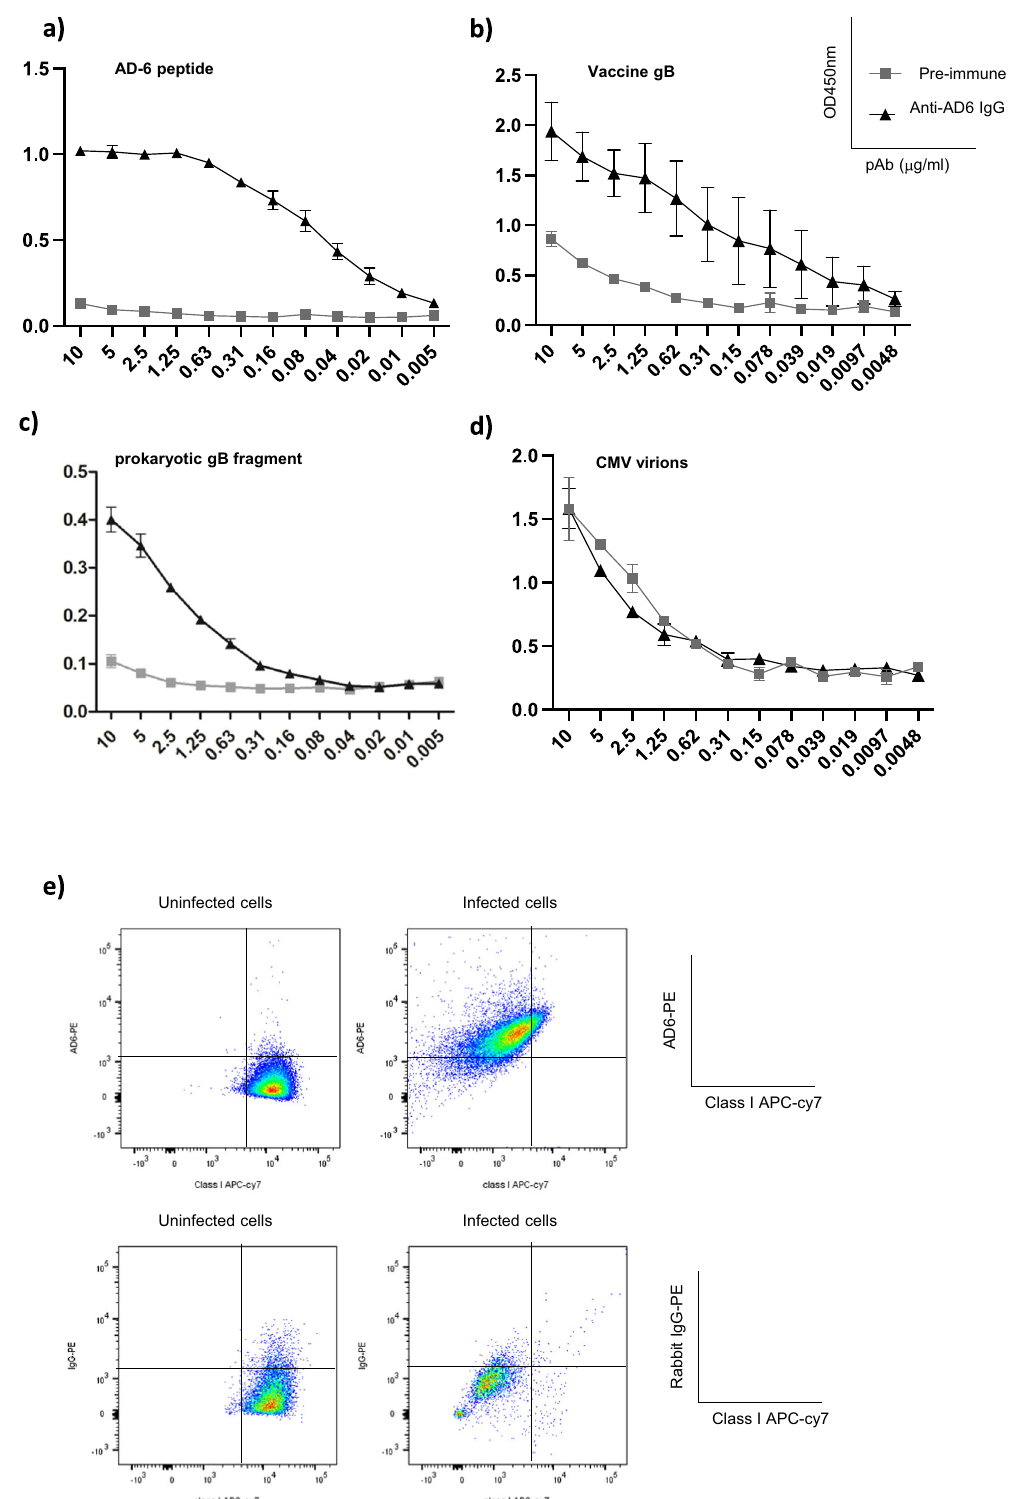
Fig. 4 | AD-6 antibodies recognise gB vaccine, recombinant gB and infected cells but not virions. a – d An anti-AD-6 polyclonal antibody was assayed by ELISA for binding to AD-6 polypeptide ( a ), vaccine gB ( b ), a commercial recombinant gB produced in E. coli ( c ) or CMV virions ( d ). Antibody levels are represented in function of absorbance (450nm) per concentration of primary antibody in μ g/mL